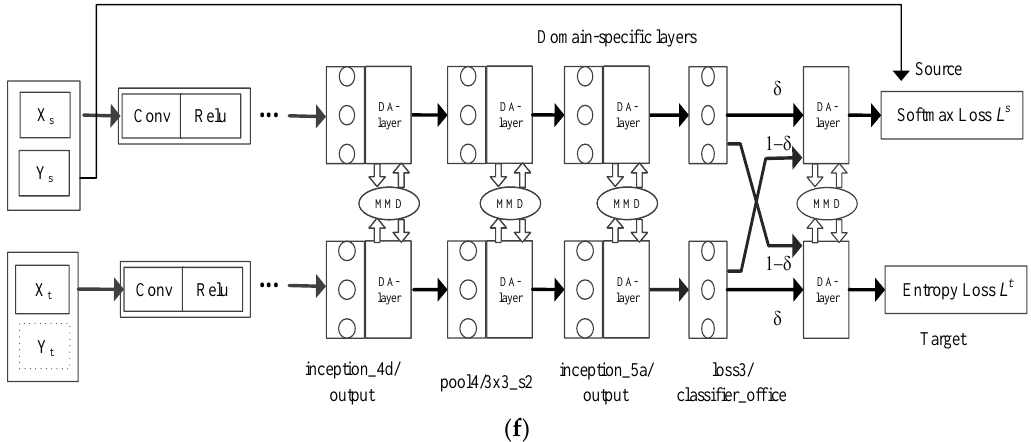
Figure 2. Network architecture: ( a ) DAN (AlexNet): AlexNet + 2MMD; ( b ) AutoDial (AlexNet): AlexNet + 3DA layer; ( c ) DAN (GoogLeNet): GoogLeNet + 4MMD; ( d ) AutoDial (GoogLeNet): GoogLeNet + 69DA layer; ( e ) JAN (GoogLeNet): GoogLeNet + 4JMMD + 1DA layer; ( f ) Ours (GoogLeNet V1): GoogLeNet + 4MMD + 4DA layer.